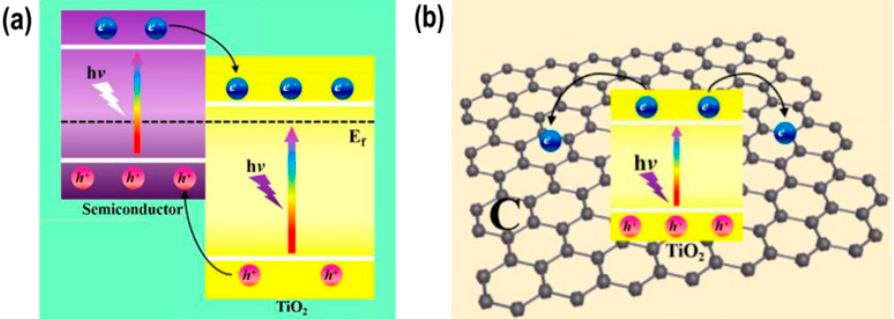
Figure 8. ( a ) Charge carrier migration mechanism of TiO 2 -based nanocomposite material, including trapping on TiO 2 and the second phase/component and ( b ) TiO 2 intercalation on the support material (example: graphene), which increases the light absorption region and intensity, charge carrier life-time, and absorptivity toward organic pollutants [81]. Table 4. TiO 2 -based heterojunction photocatalysts for organic pollutant treatment. Several images in the table are reproduced with permission from Elsevier, 2022.